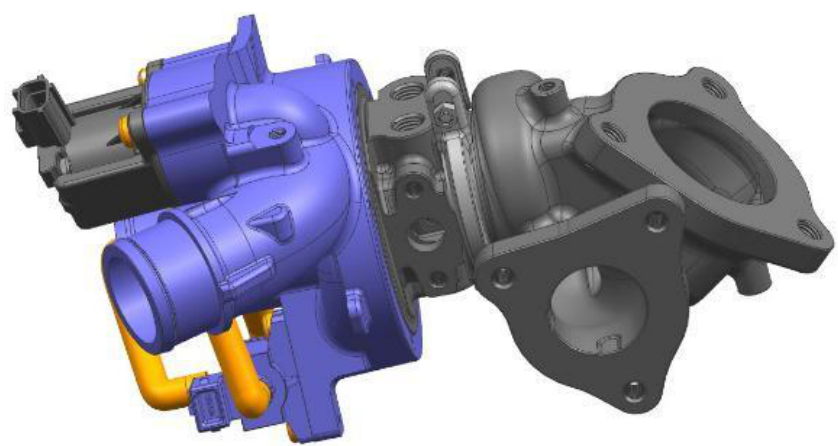
Figure 2. Three-dimensional structure model. Table 1. Turbocharger parameters.